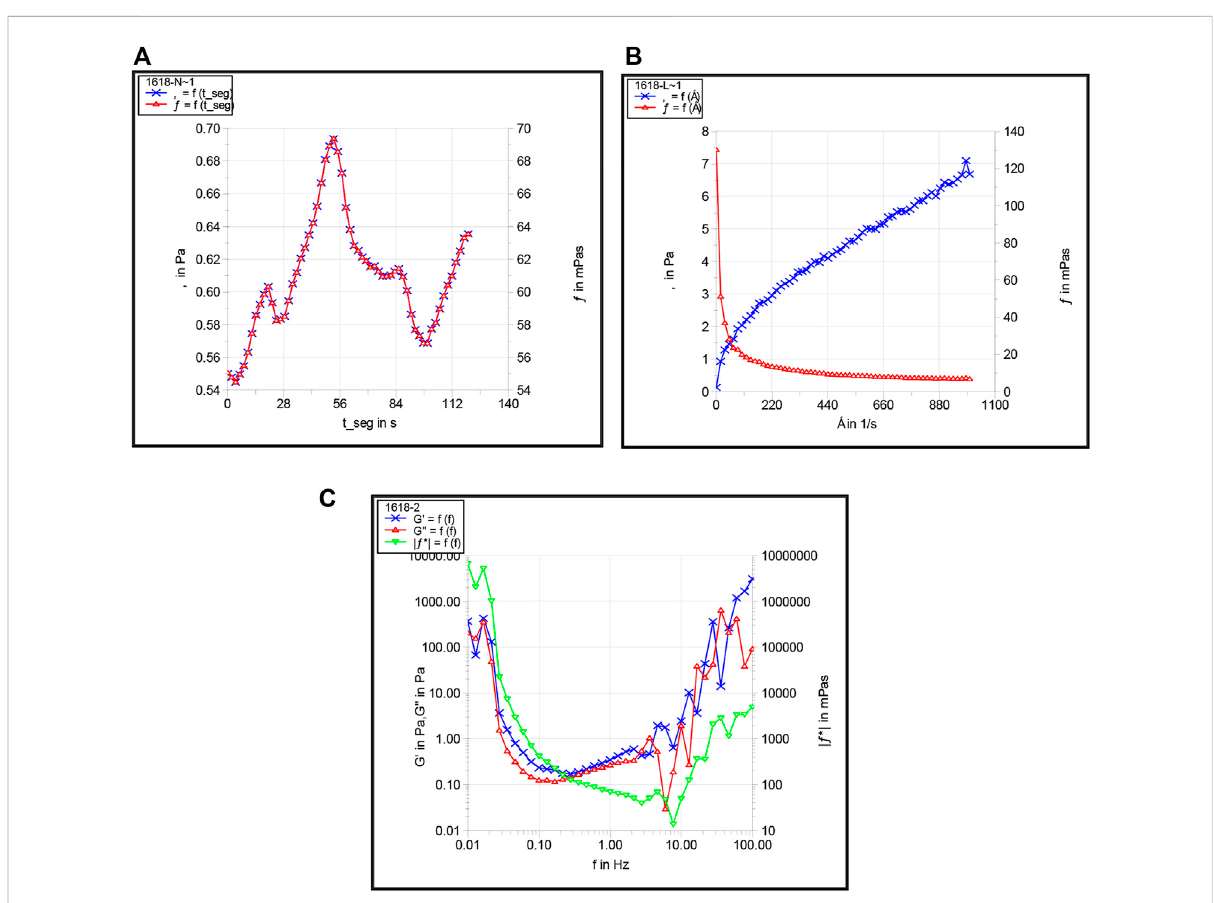
FIGURE 12 Apparent viscosity (A) , shear thinning (B) , and viscoelasticity (C) of the preferred foam